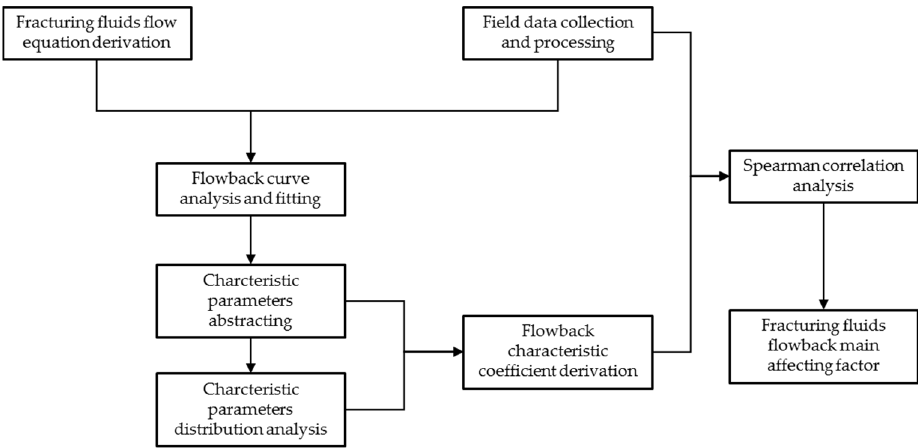
Figure 1. Schematic diagram of the approach used in the study 2. Research area background and analysis data.